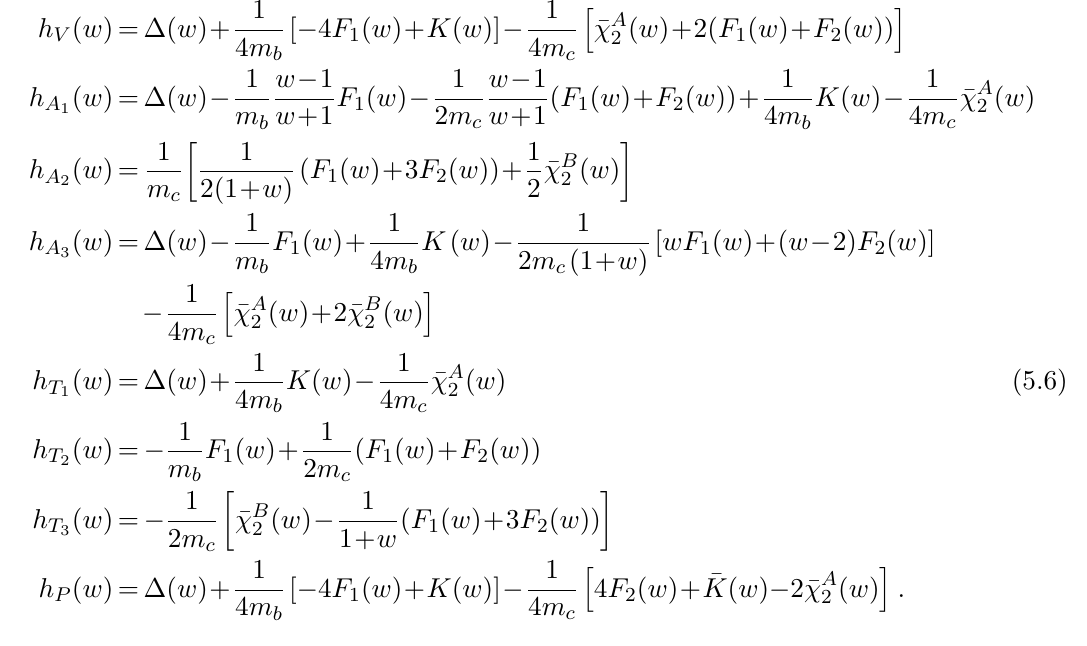
figure 1. Keeping the leading term in the heavy quark mass expansion leads to h = ∆ and h = 0 , relations badly violated by the results obtained by lattice QCD, h A 3 A 2